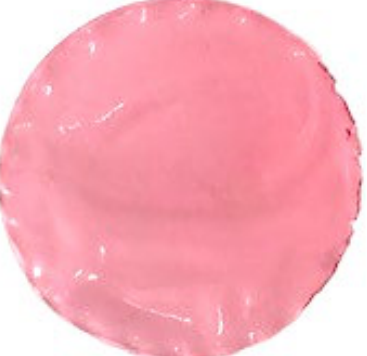
Figure 3. Macroscopic appearance of the optimized starch-PEJP film formulation.